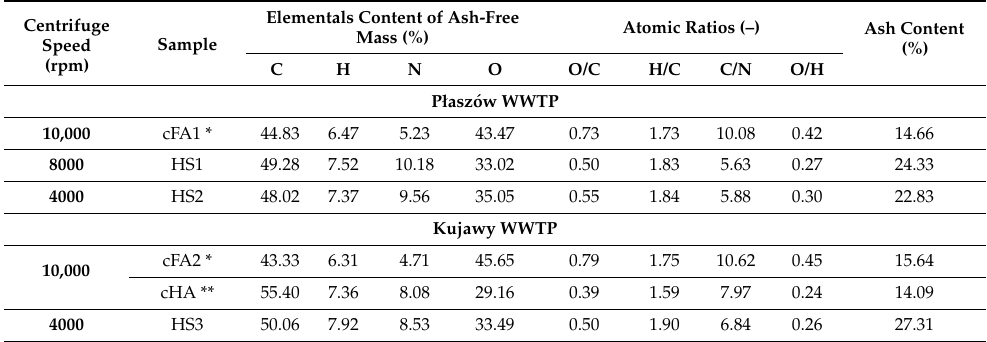
Table 4. Elemental composition and its atomic ratios for HS extracted from digested sludge according to the classical (IHSS) and author’s method.